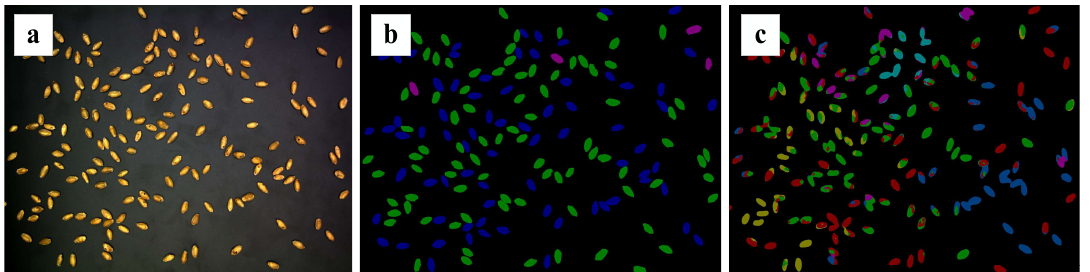
Figure 1. Ground truth and U-Net segmentation results: ( a ) original image; ( b ) ground truth; ( c ) U-Net result.